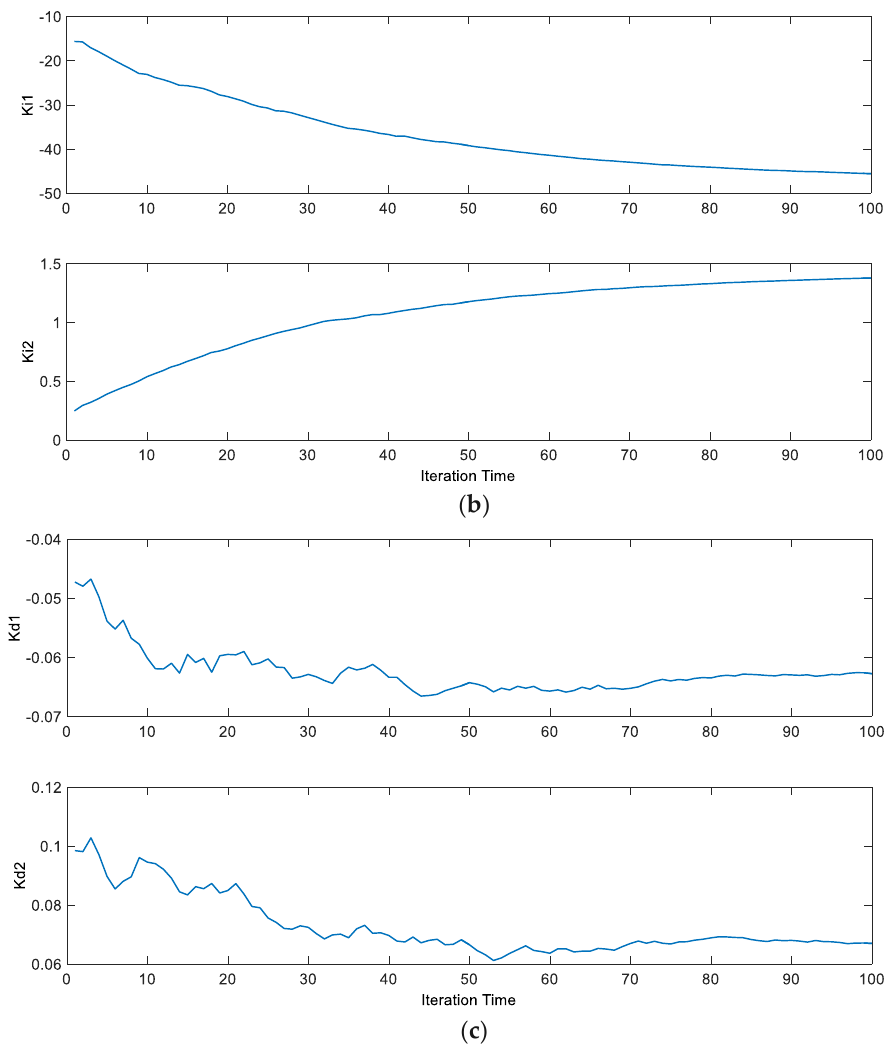
Figure 10. The trend curves of the parameters of the controller: ( a ) the trend curves of K p 1 and K p 2 ; ( b ) the trend curves of K i 1 and K i 2 ; ( c ) the trend curves of K d 1 and K d 2 .